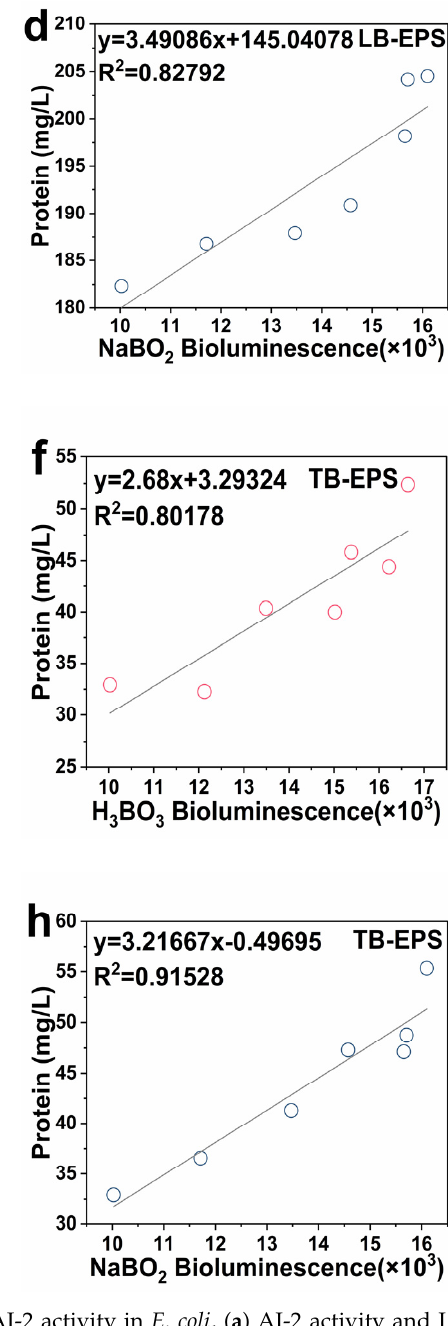
Figure 6. Linear correlation analysis of EPS and AI-2 activity in E. coli , ( a ) AI-2 activity and LB-EPS-polysaccharide under H 3 BO 3 treatment, ( b ) AI-2 activity and LB-EPS-protein under H 3 BO 3 treatment, ( c ) AI-2 activity and LB-EPS-polysaccharide under NaBO 2 treatment, ( d ) AI-2 activity and LB-EPS-protein under NaBO 2 treatment, ( e ) AI-2 activity and TB-EPS-polysaccharide under H 3 BO 3 treatment, ( f ) AI-2 activity and TB-EPS-protein under H 3 BO 3 treatment, ( g ) AI-2 activity and TB-EPS-polysaccharide under NaBO 2 treatment, and ( h ) AI-2 activity and TB-EPS-protein under NaBO 2 treatment.